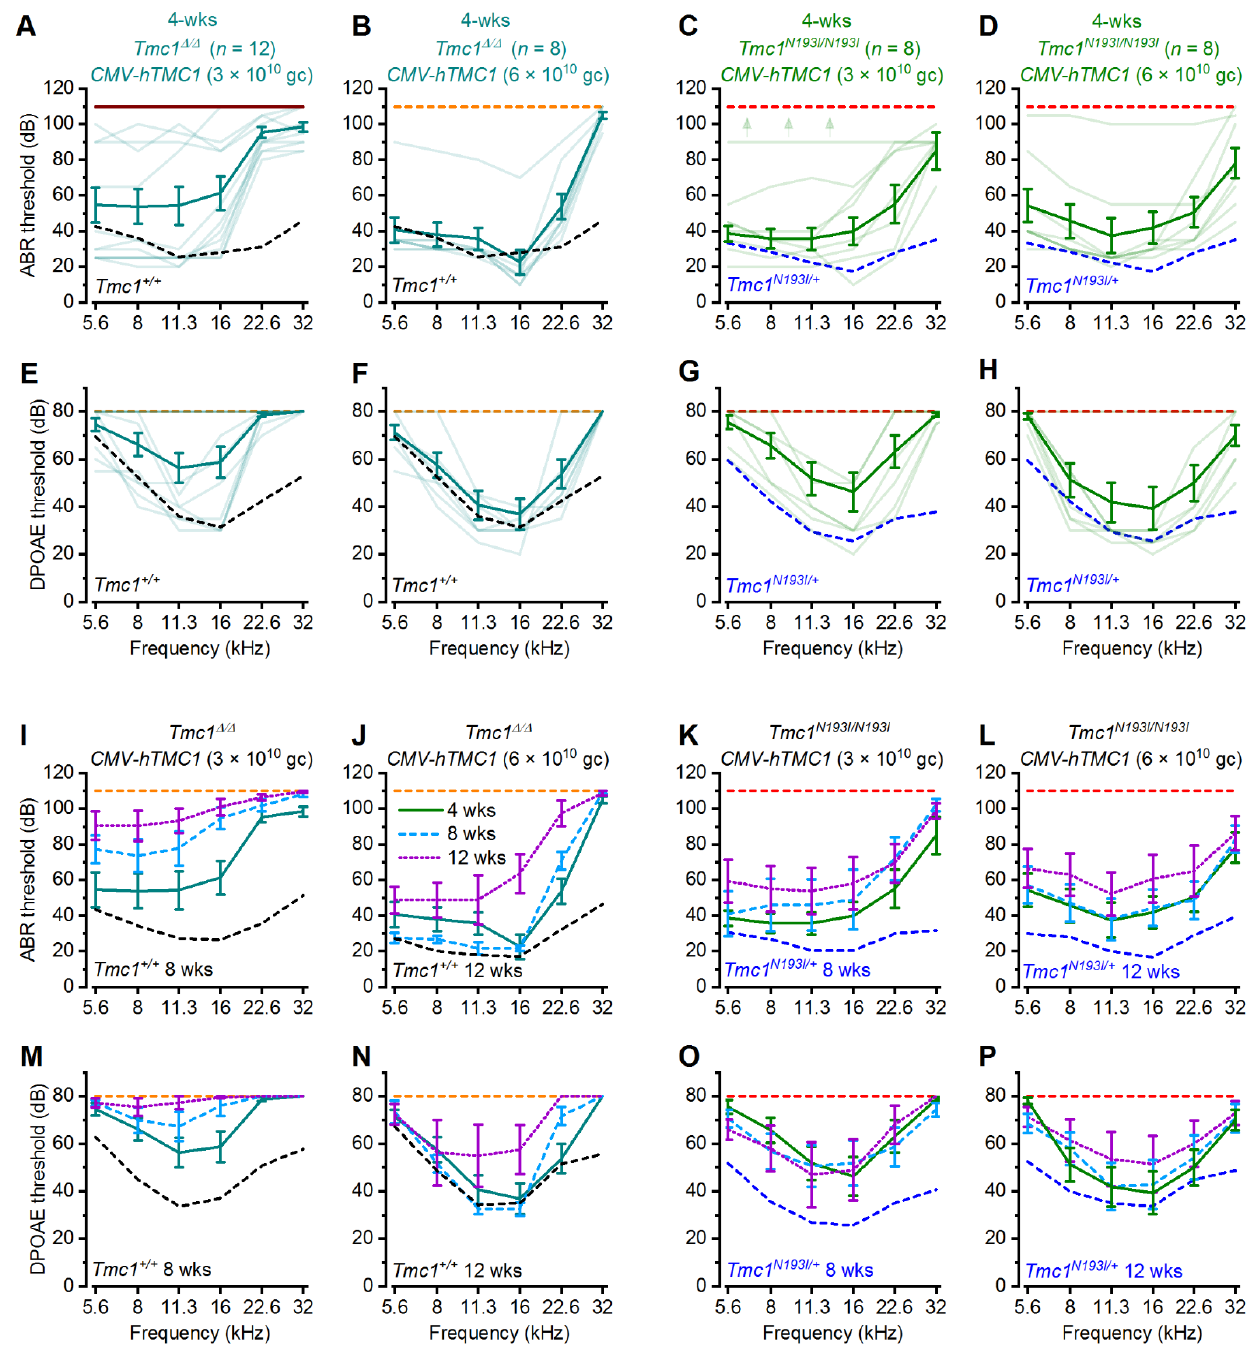
Figure 2. Deaf mice treated with AAV2/9-PHP.B -CMV-hTMC1 efficiently recover low and middle frequency auditory thresholds. ABR ( A – D ) or DPOAE ( E – H ) thresholds as a function of frequency of Tmc1 Δ / Δ ( A , B ), ( E , F ) and Tmc1 N193I/N193I ( C , D ), ( G , H ) mice injected at P1-2 with CMV-hTMC1 at a titer of 3 × 10 13 gc/mL ( A , C , E , G ) or 6 × 10 13 gc/mL ( B , D , F , H ) at 4 weeks of age. Mean ± S.E.M. thresholds shown in bold traces and individual recording are shown as lighter traces. Mean ± S.E.M. ABR ( I – L ) or DPOAE ( M – P ) thresholds against frequency across time for injected 4-, 8-, and 12-week-old mice. Dashed lines indicate mean ABR or DPOAE thresholds for uninjected control mice: Tmc1 Δ / Δ (orange), Tmc1 +/+ (black) (4-week-old: ( A , B , E , F ); 8-week-old: ( I , M ); 12-week-old: ( J , N ) and Tmc1 N193I/N193I (red), Tmc1 N193I/+ (blue) (4-week-old: ( C – D , G , H ); 8-week-old: ( K , O ); 12-week old: ( L , P ).